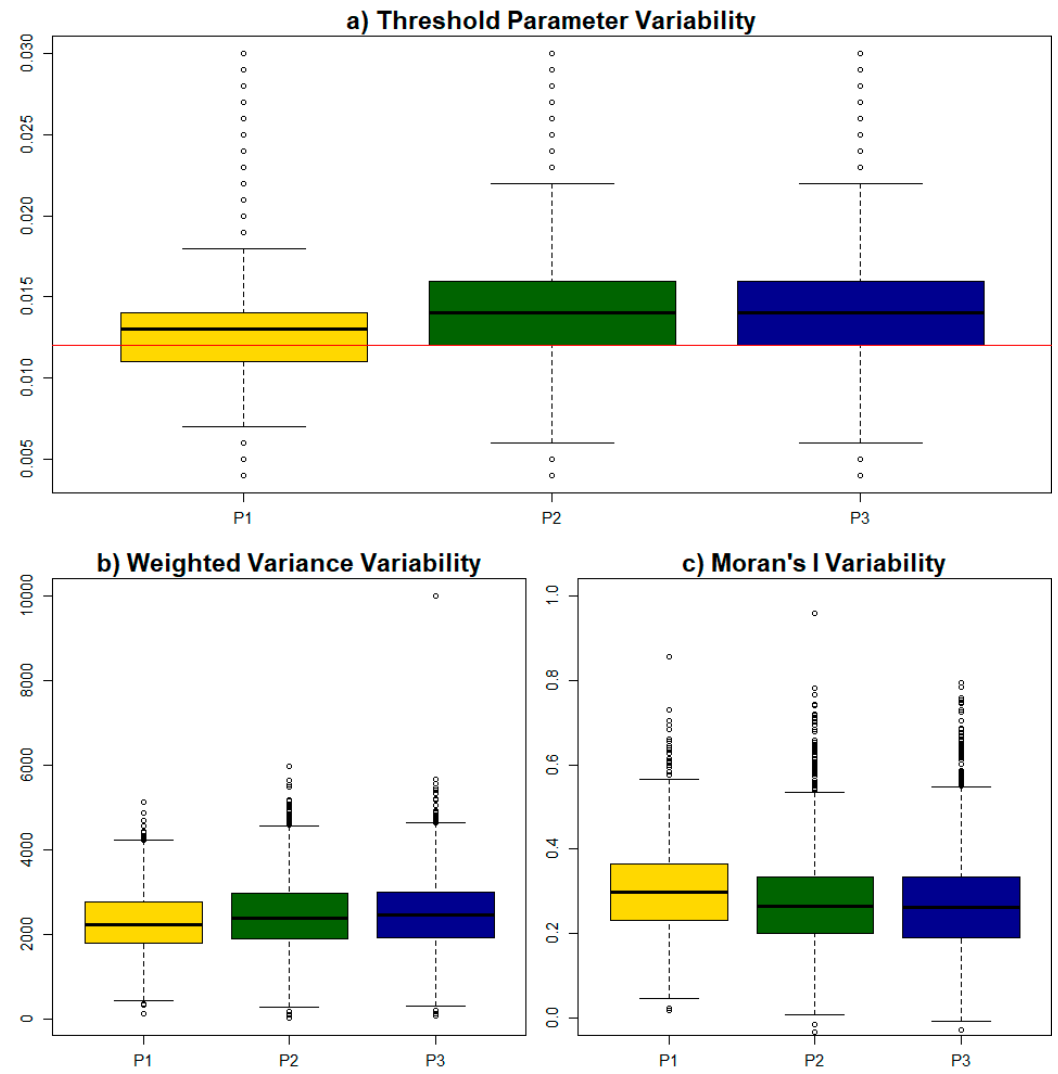
Figure 8. Boxplots demonstrating the variability of ( a ) the TP, ( b ) MI and ( c ) WV for the different partitioning approaches (P1, P2, P3).